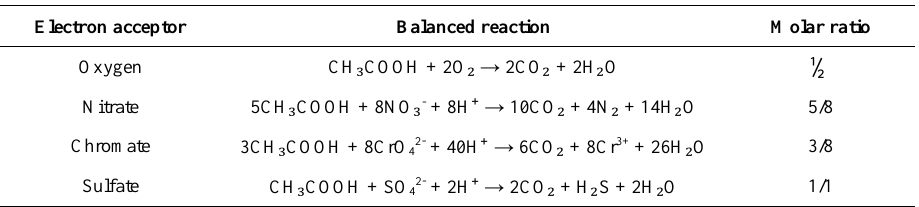
Table 1. Calculated molar ratios of stoichiometric electron donor demand for redox reactions of anaerobic metabolic